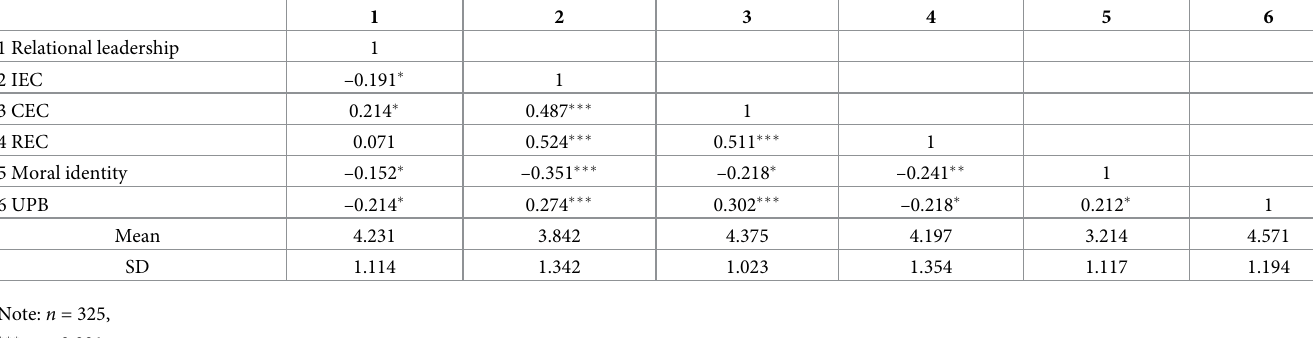
Table 2. Mean, standard deviation, and correlation coefficient matrix of the main